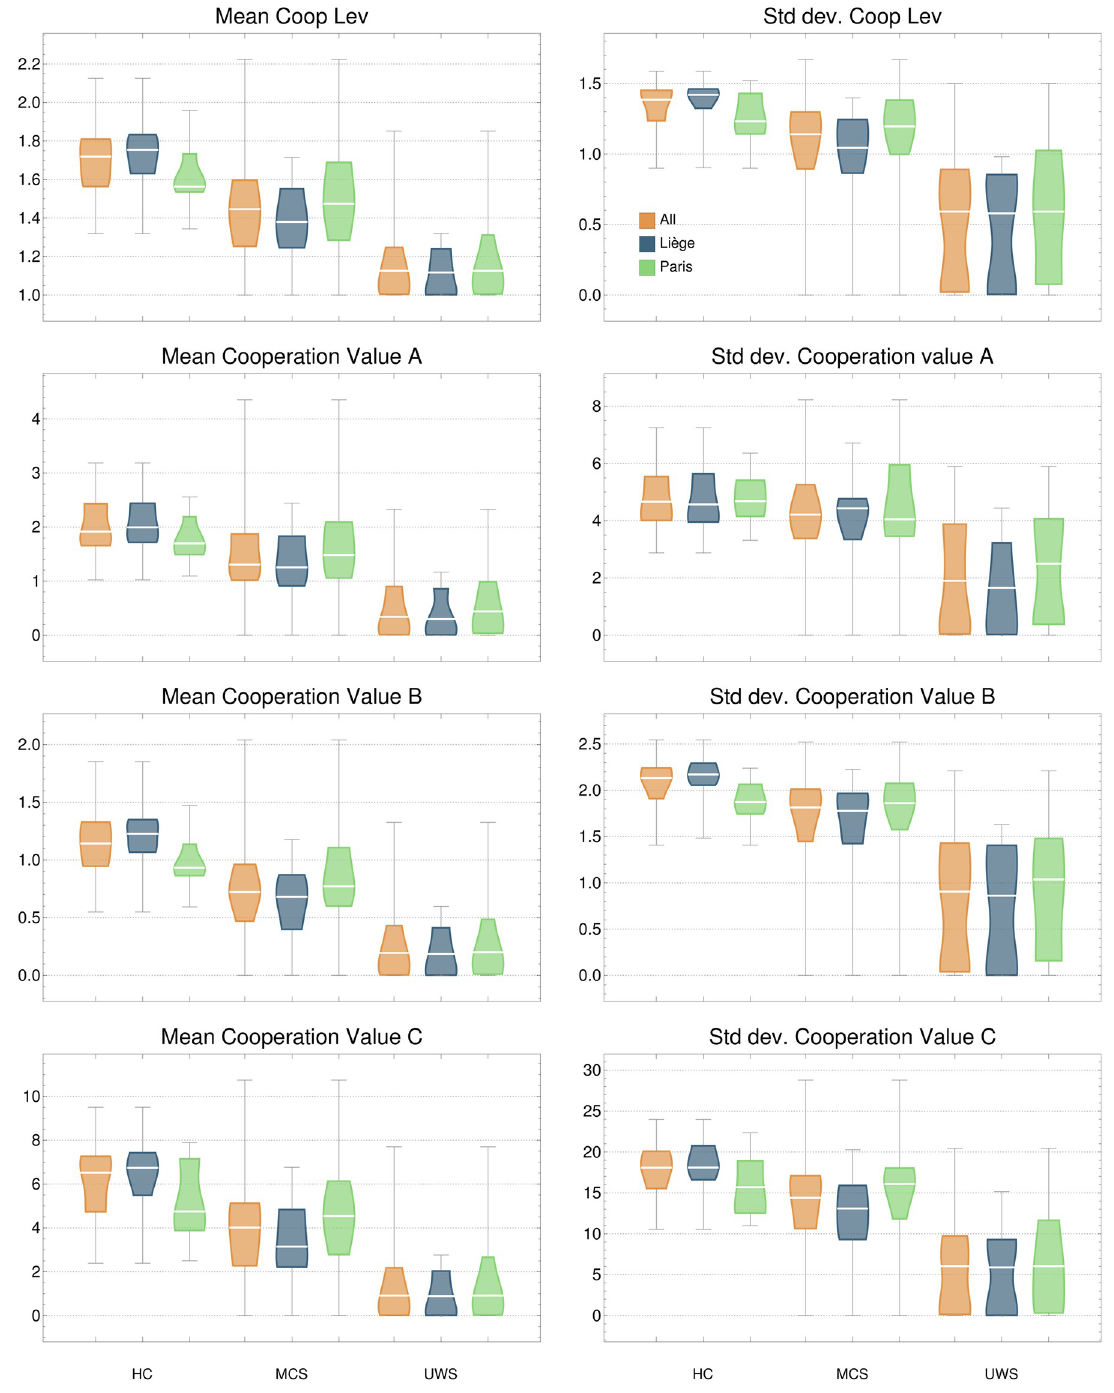
Fig 6. Distributions of cooperation measures. These measures consider in several ways the cooperative interactions between different networks (Fig 2). It can be observed that the higher the consciousness level, the more cooperation is in the IS (mean) and with a higher variability (standard